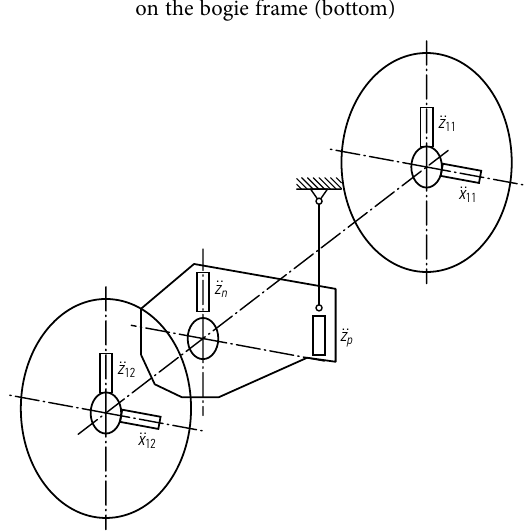
Fig. 3. The layout of accelerometric sensors on the wheelset with the symbols of the measured quantities (accelerations in the x and z